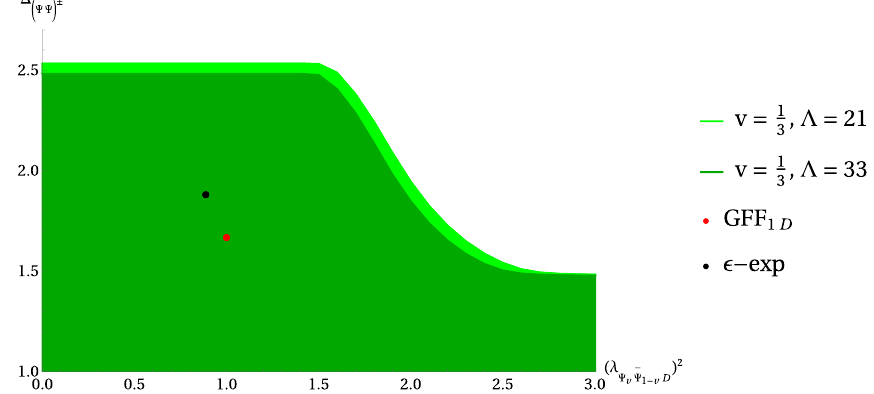
versus the (Ψ¯Ψ) ± ) 2 . v = 1 and the gaps on the dimension Ψ v ¯Ψ 1 − v D 3